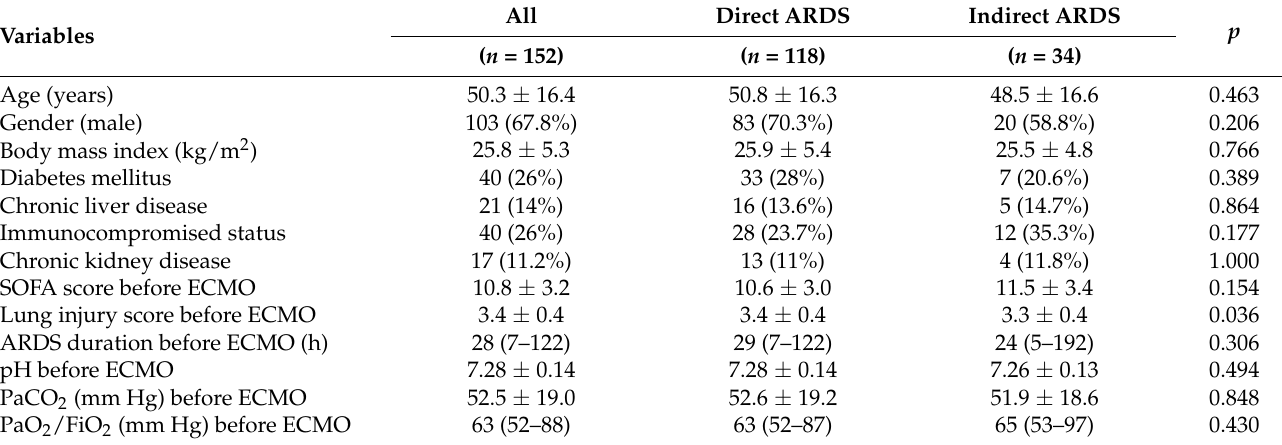
Figure 1. Flow diagram of enrolling patients with severe ARDS with ECMO support. (ARDS, acute respiratory distress syndrome; ECMO, extracorporeal membrane oxygenation). Table 1. Background characteristics and clinical variables: Direct and indirect ARDS